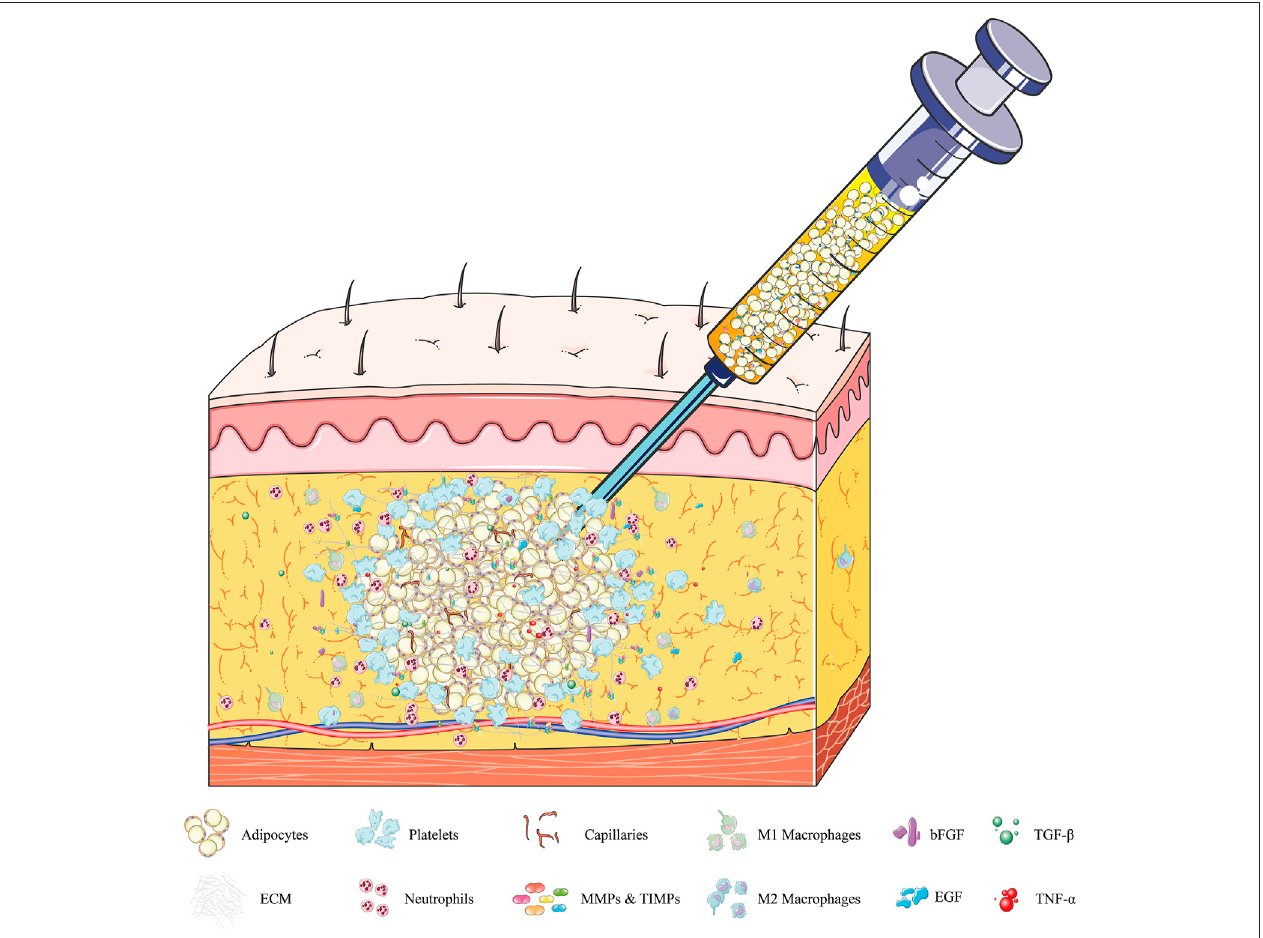
FIGURE 1 | Dynamic regulation of adipose ECM within 72 h after fat grafting. Local hemorrhage after injection of fat grafts at the recipient area activates platelet cascade reactions. The adipocytes are covered by platelets and form clots within a few hours. The thin layers of fi bers (fragile collagen) secreted by platelets and myo fi broblasts form a loose connection between adipose lobules and “ broken ” ECM within 24 h. During this period, dying adipocytes, SVF, and “ broken ” ECM secrete variouscytokines,includingbFGF,TNF- α ,TGF- β ,andEGF;damage-relatedmolecularpatternmolecules;andsomeproteases,primarilyMMPsandTIMPs.These factors recruit in fl ammatory cells (mainly neutrophils and macrophages), activate regenerative cells (such as stem cells and endothelial cells), and promote ECM synthesis, all of which play pivotal roles in the regeneration process. Abbreviations: SVF, stromal vascular fraction; bFGF, basic fi broblast growth factor; TNF- α , tumor necrosisfactor- α ; TGF- β ,transforminggrowth factor- β ; EGF, epidermal growth factor; MMPs, matrix metalloproteinases; TIMPs,tissue inhibitorsofmetalloproteinases.